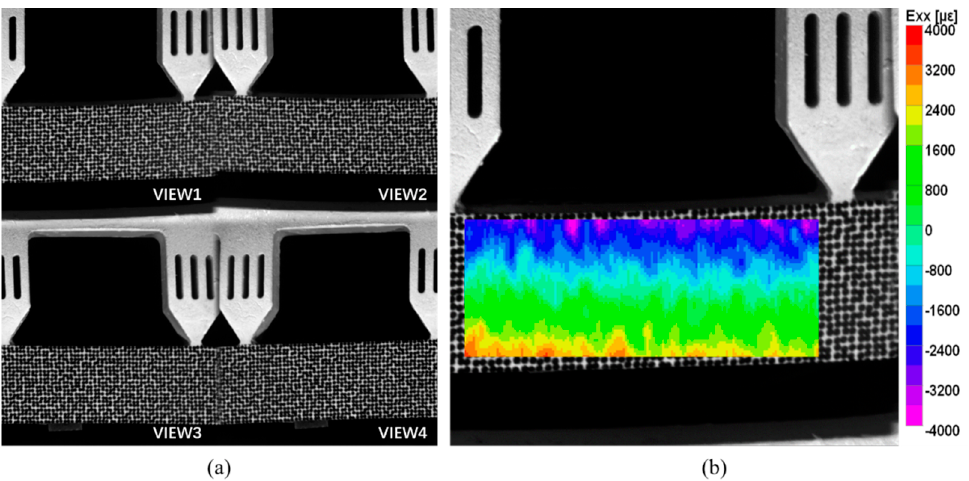
Figure 14. ( a ) Speckle image of the four-point bending beam from four views in the experiment; ( b ) full-field strain ε xx of the pure bending section.